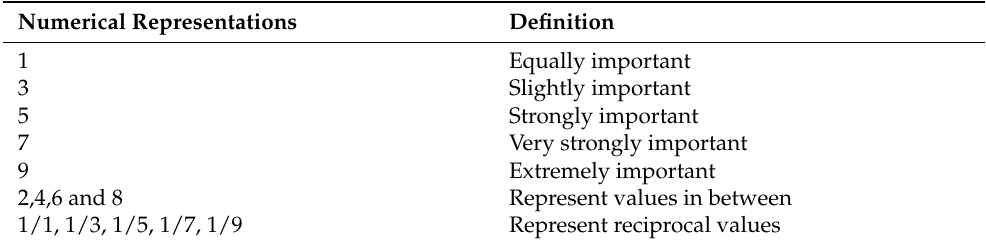
Table 4. Saaty’s basic scale of absolute numbers